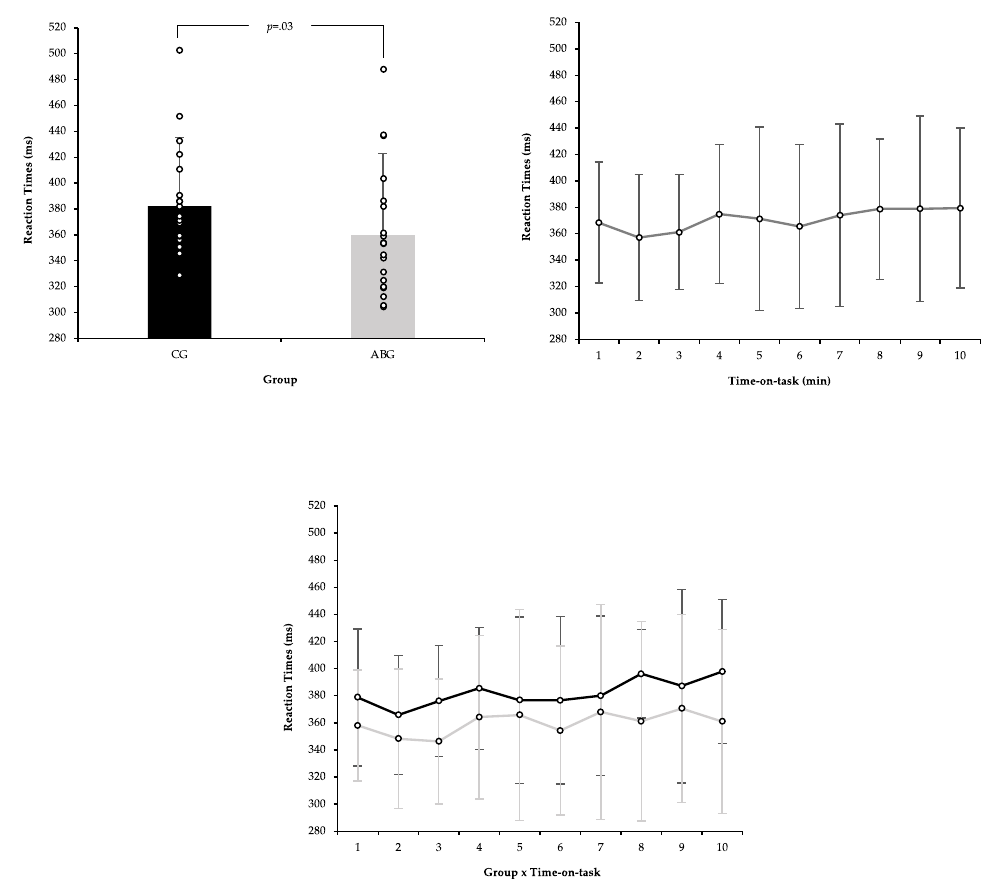
Figure 5. Mean RT (± SE) as a function of Group Condition, time-on-task and Group x time-on-task. Figure 5. Mean RT ( ± SE) as a function of Group Condition, time-on-task and Group x